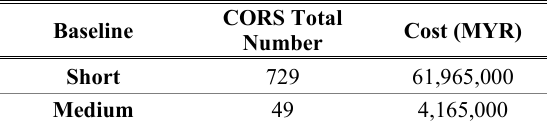
Table 4. Total number distribution of CORS within designed frame.